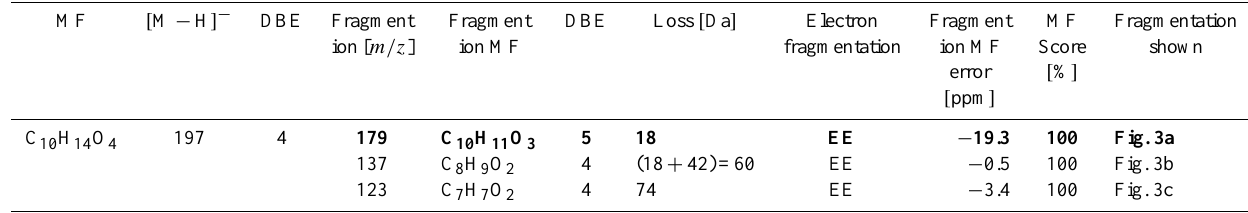
Table 4. Deprotonated molecular species fragmentation for compound 5, obtained from the use of the HPLC-ITMS 2 and the HPLC-QTOFMS 2